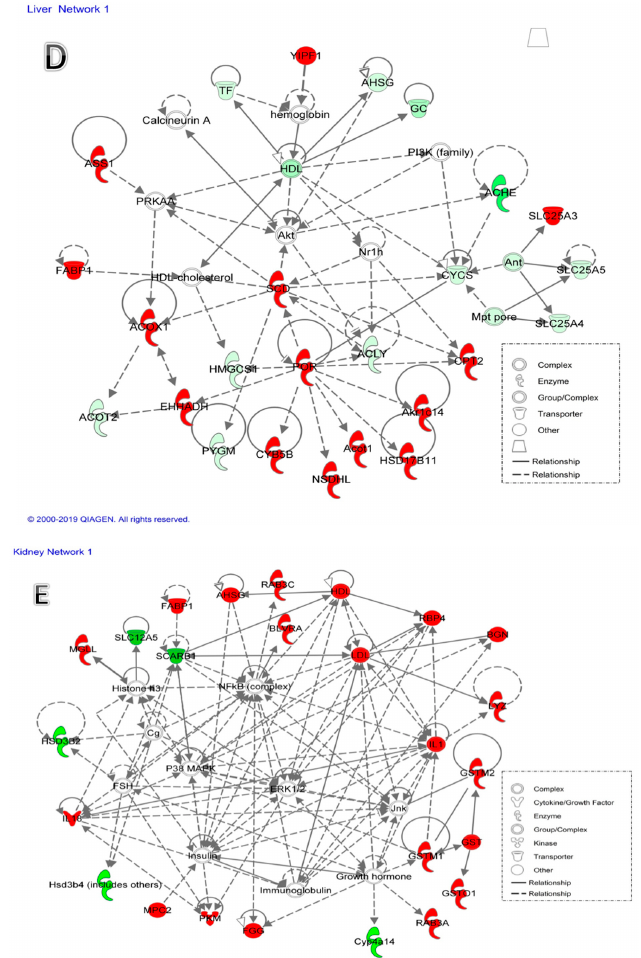
Figure 5. Network analysis of the di ff erentially expressed proteins between the Dex-treated and control rats identified by the IPA (ingenuity pathway analysis). ( A ) Brain network pathway converged on the central signaling pathway involving extracellular signal–regulated kinases (ERK1 / 2), janus kinase (Jnk), and Akt. The network with the highest score related to cell morphology, nervous system development, and function and neurological disease (score = 38). ( B ) Heart network pathway identified the involvement of Akt and phosphoinositide 3-kinase (PI3 kinase) signaling pathways. The network with the highest score related to cellular development, cellular function and maintenance, and connective tissue development and function (score = 43). ( C ) Skeletal muscle network pathway identified with the highest scoring network (score = 50) related to nucleic acid metabolism, small molecule biochemistry, and vitamins and mineral metabolism. ( D ) Liver network pathway was identified with the highest scoring network (score = 41) related to lipid metabolism, small molecule biochemistry, and nucleic acid metabolism. ( E ) Kidney network pathway was identified with the highest scoring network (score = 41) related to drug metabolism, organism injury, and abnormalities and renal damage. Nodes in green and red correspond to down- and upregulated proteins, respectively. Non-colored nodes were proposed by IPA and suggest potential targets functionally coordinated with the di ff erential proteins. Solid lines indicate direct molecular interactions and dashed lines represent indirect